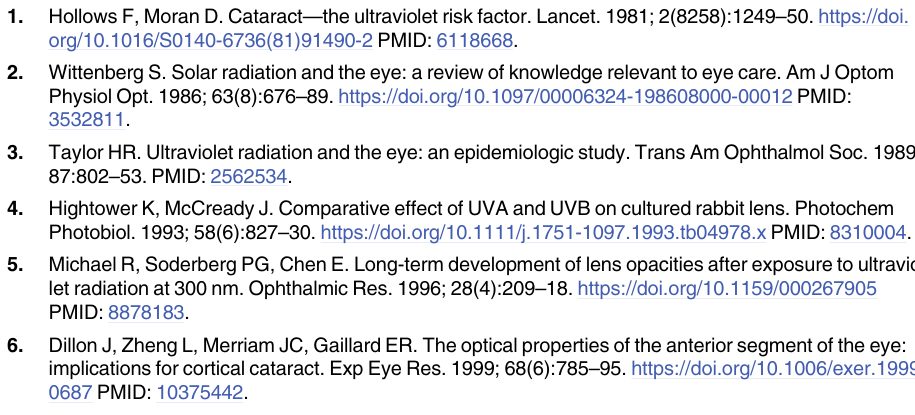
S2 Table. Demographics of the cross-sectional samples examined for the risk of the five types of cataract for two-, three- and four-fold cumulative ocular UV exposure (COUV) based on the mean COUV in Japanese people [Table 5]. S3 Table. Demographics of the cross-sectional samples examined for the COR (axle- shaped, wedge-shaped, and ring-shaped) risk of the high cumulative ocular UV exposure (COUV) group compared with the low COUV group [Table